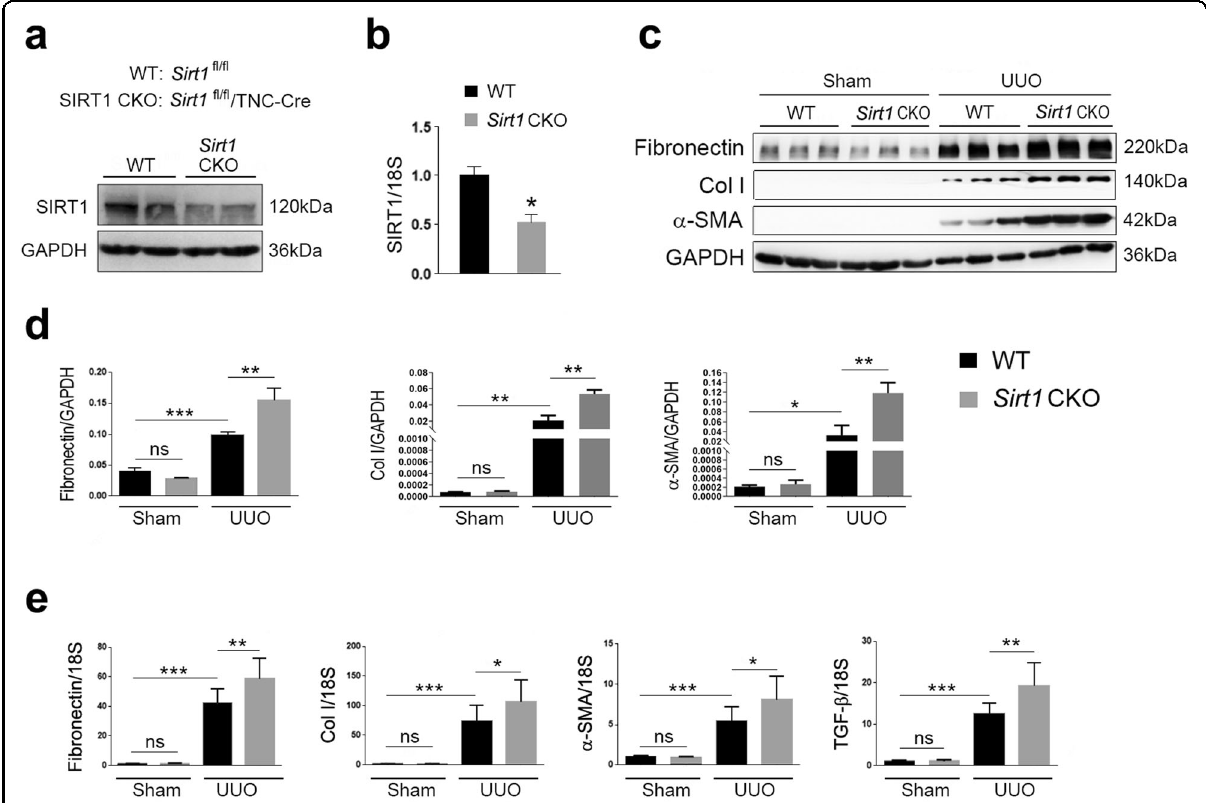
Fig. 2 SIRT1 de fi ciency aggravates UUO injury in the kidney. a SIRT1 was decreased in the kidney in kidney conditional knockout mice ( Sirt1 CKO). Protein levels were analyzed by western blot analysis and GAPDH was used as a loading control. b SIRT1 mRNA levels in the kidney were also reduced in Sirt1 CKO mice. c SIRT1 de fi ciency further exacerbates kidney fi brosis induced by UUO surgery. Protein levels were analyzed by western blot analysis and GAPDH was used as a loading control. d Quanti fi cation of western blot data as shown in c . e Sirt1 de fi ciency in the kidney stimulates kidney fi brosis-related gene expressions in UUO mice. Gene expression was analyzed by qRT-PCR and 18S has used a house-keeping gene. n = 6. Data are means ± SEM. * P < 0.05, ** P < 0.01, and *** P < 0.001. ns means no signi fi